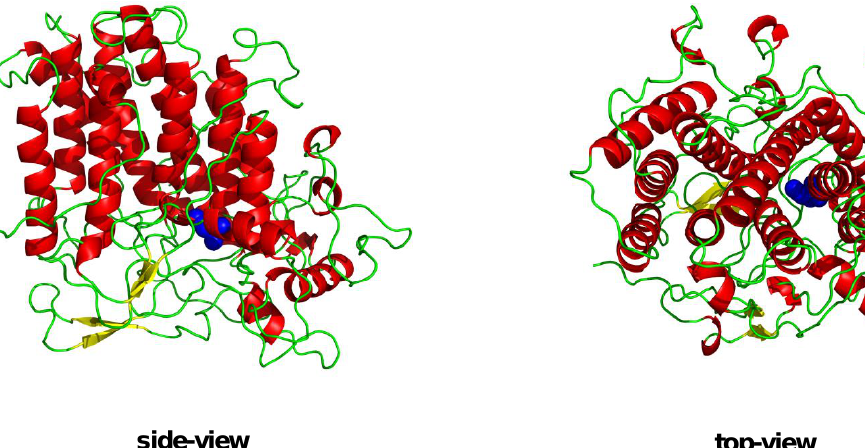
Figure 5. Crystal structure of the vanadium chloroperoxidase from C. inaequalis (PDB 1VNC) where we highlight the side-by-side four α -helix loops common to all vanadium haloperoxidases. The vanadium cofactor (blue) is anchored at the bottom of this channel. The structure is shown in the cartoon representation with the secondary structure highlighted; red are α -helixes, green are loops, and yellow are β -sheets.